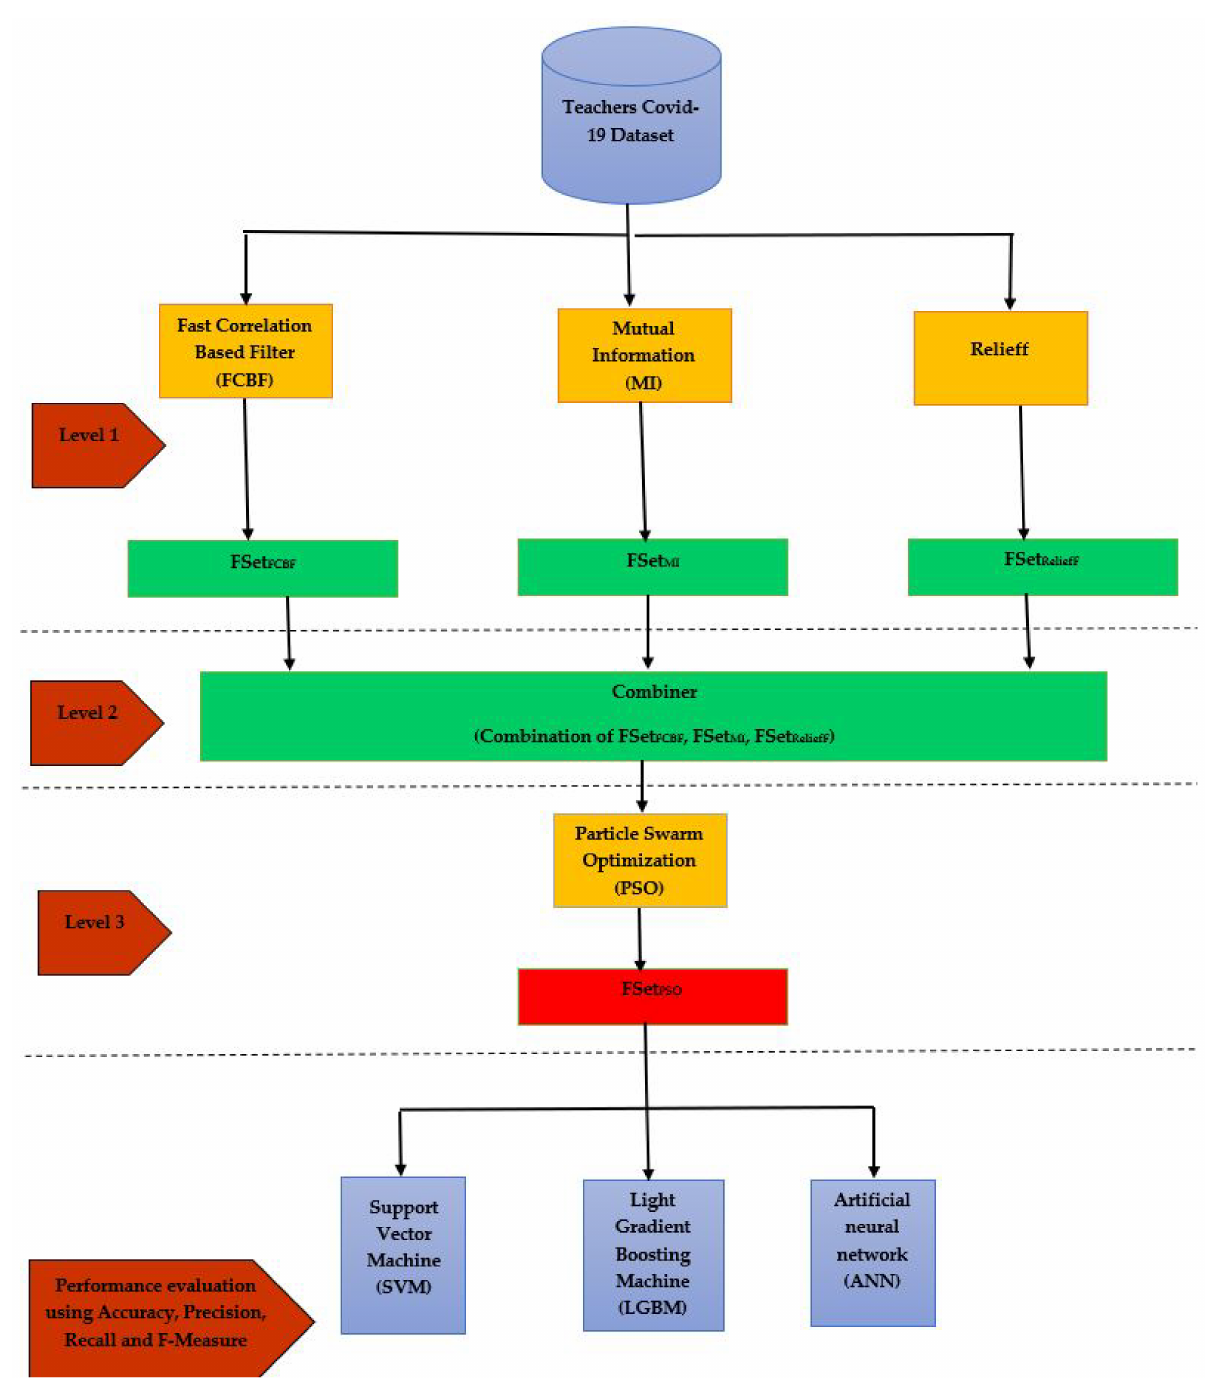
Figure 1. Proposed Approach for Identifying the Factors Affecting the satisfaction of Teachers during